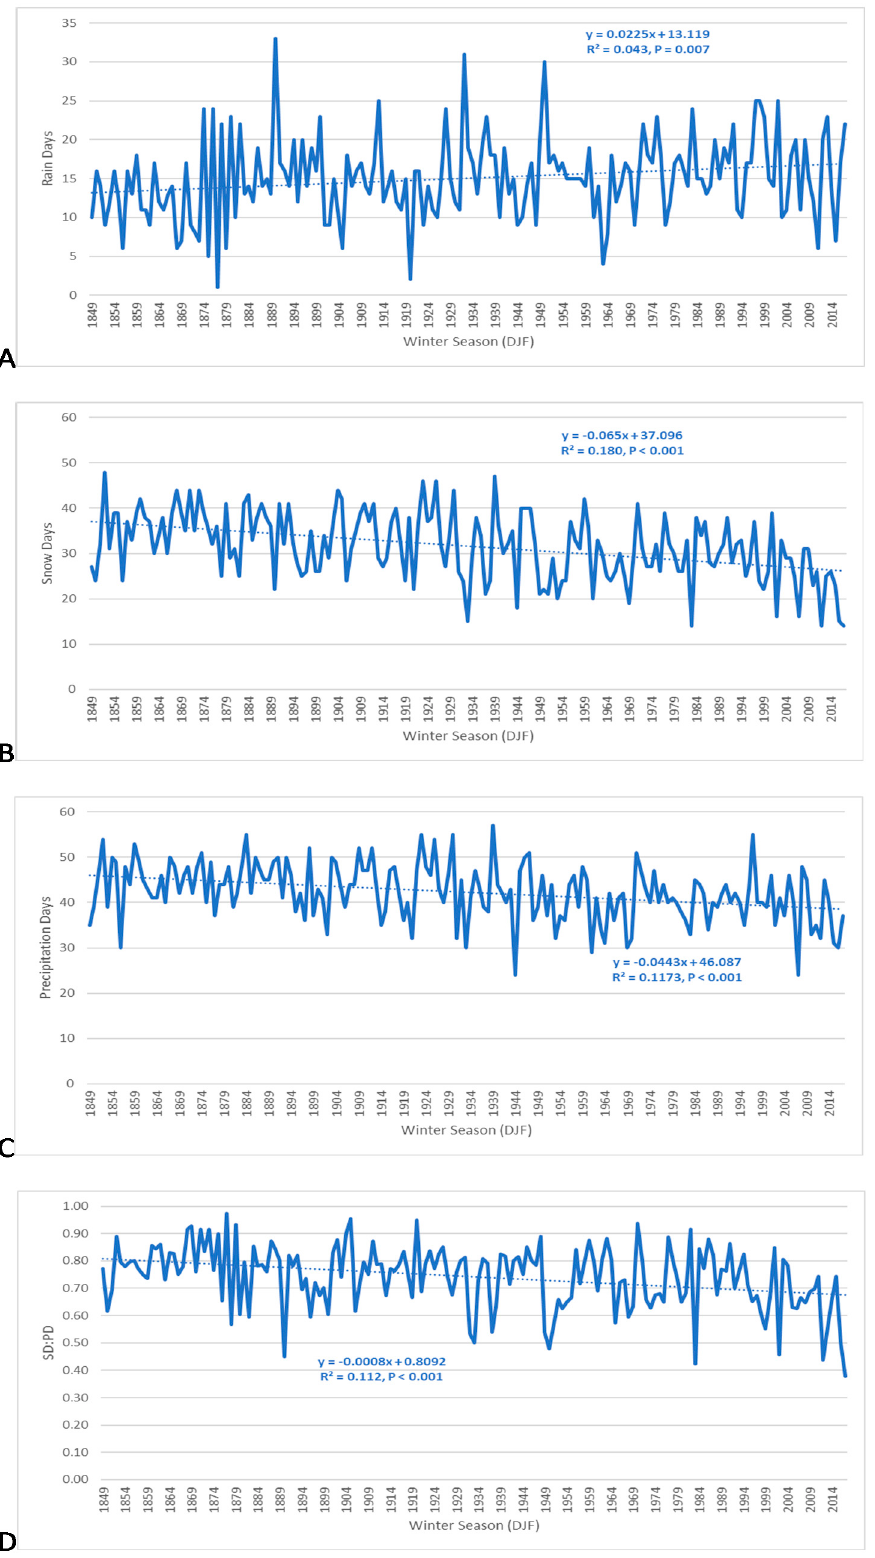
Figure 2. Trends in ( A ) rain days, ( B ) snow days, ( C ) precipitation days, and ( D ) ratio of snow days to precipitation days (SD:PD), for winters in Toronto